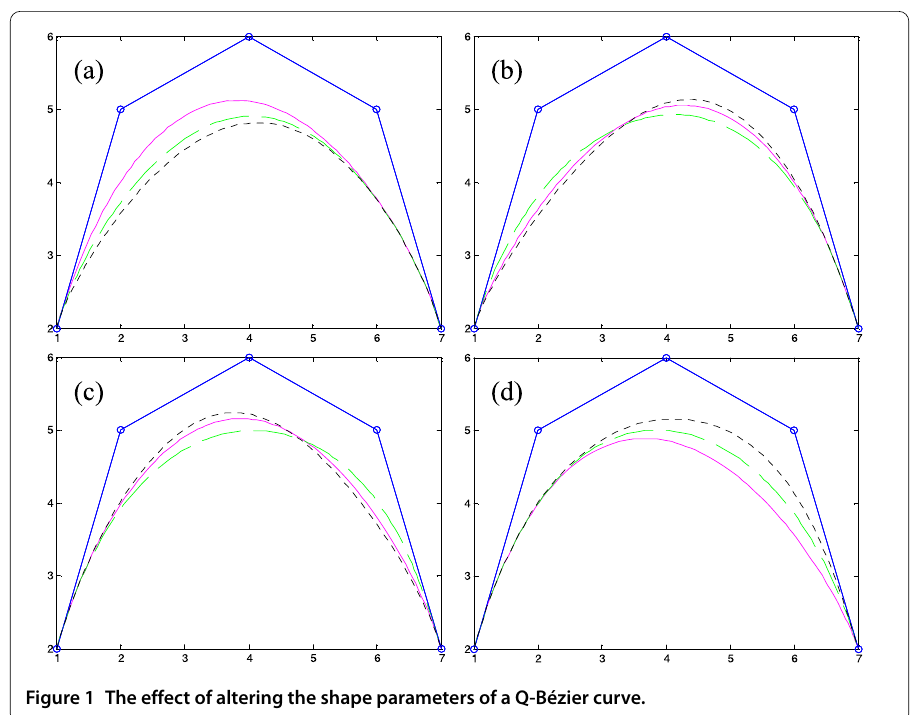
Figure 1 The effect of altering the shape parameters of a Q-Bézier